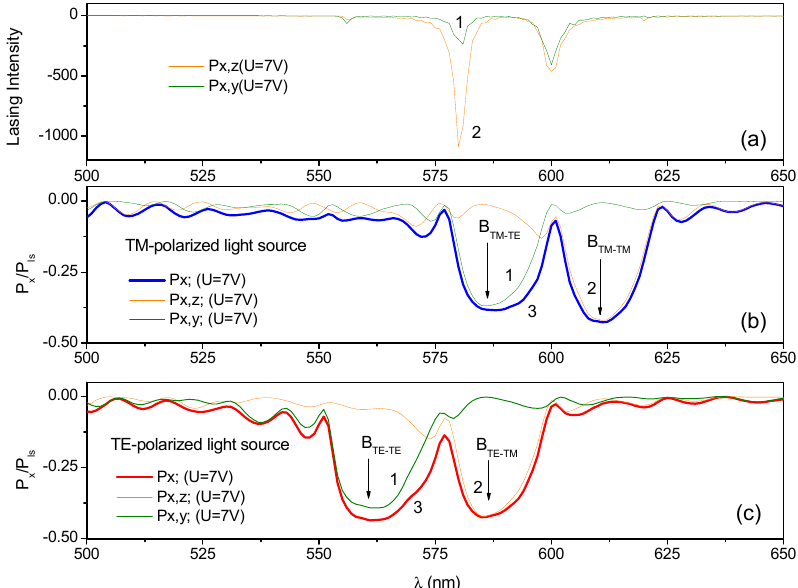
Figure 7. Spectra of the lasing effect ( a ) and corresponding reflection spectra for the case of a strongly deformed (U = 7 V) lying helix. The curves 1 and 2 correspond to y- and z-polarized light of the x-component of the Poynting vector (P x,y and P x,z ), respectively. The curves labelled 3 are for the total P x energy flux. The spectra ( b , c ) are for the z-(TM) and y-polarized (TE polarization) incident light.